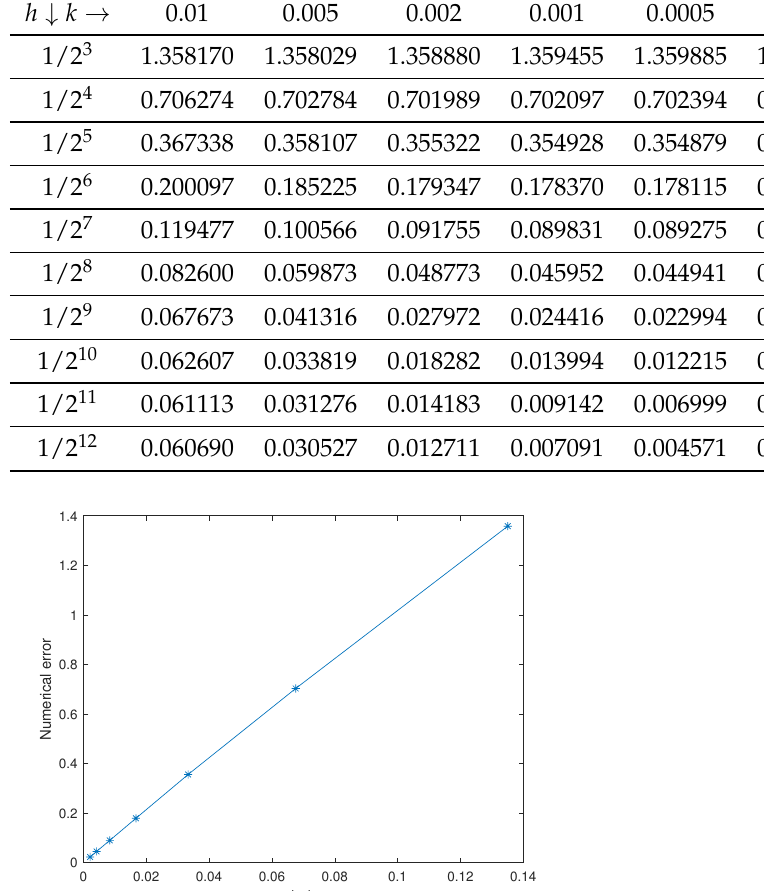
Table 1. Example 1: numerical errors for some values of h and k .